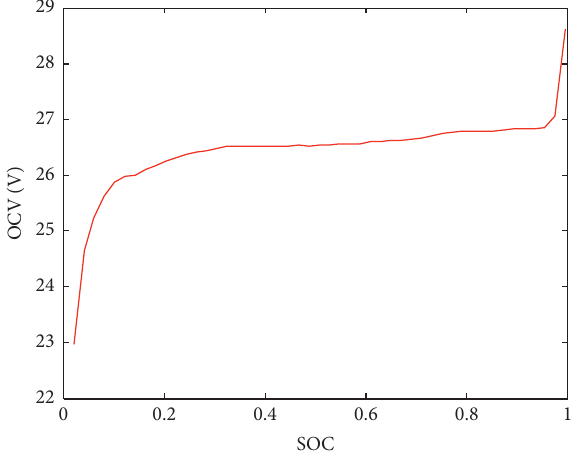
Figure 7: OCV-SOC fitting curve.